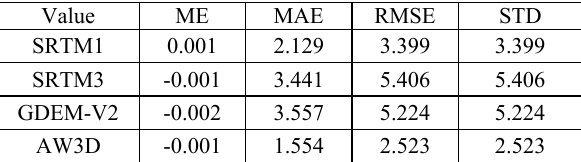
Table 1. Relative Error of typical DEM datasets